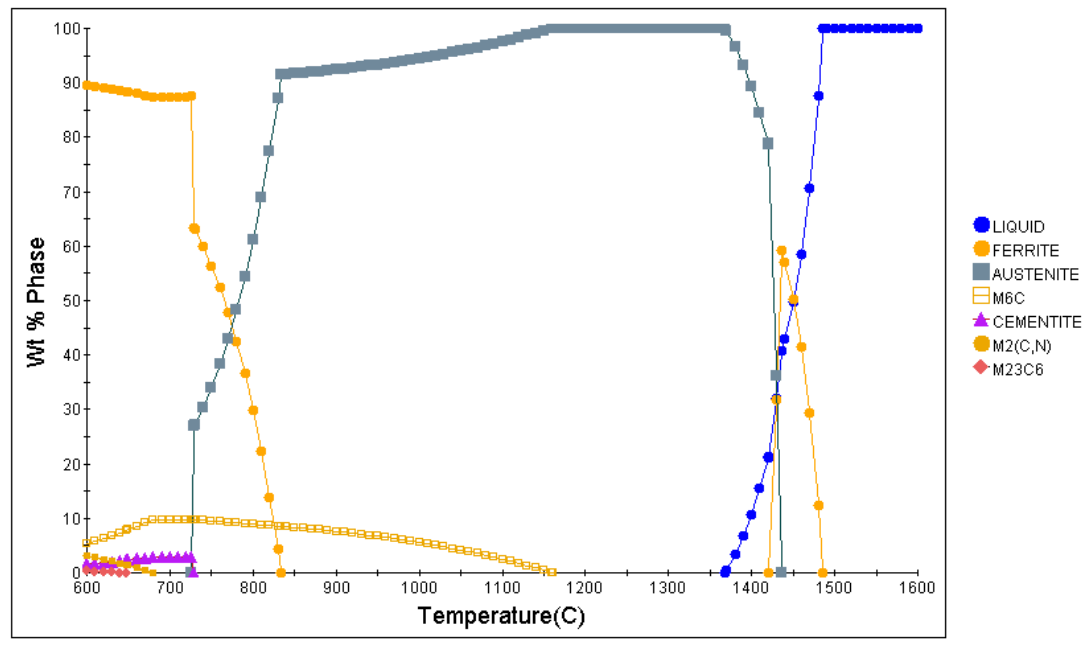
Figure 5. Equilibrium phase fraction by JMatPro software of HTCS-150 steel.